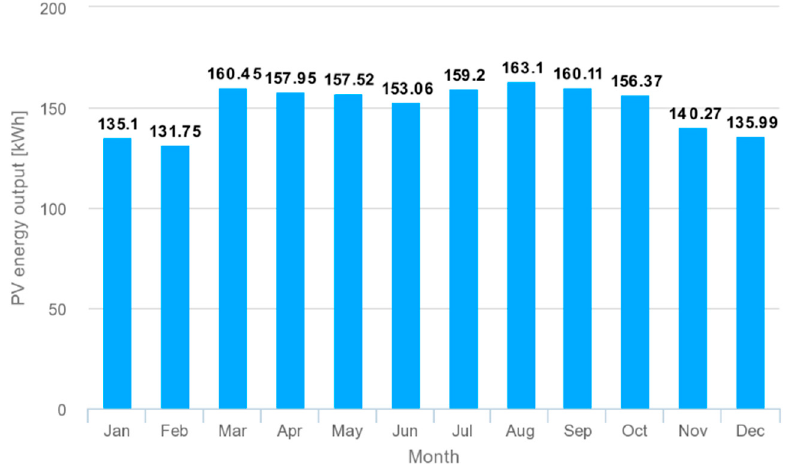
Figure 9. Monthly energy output from a fixed-angle PV system in Cairo, Egypt [35].